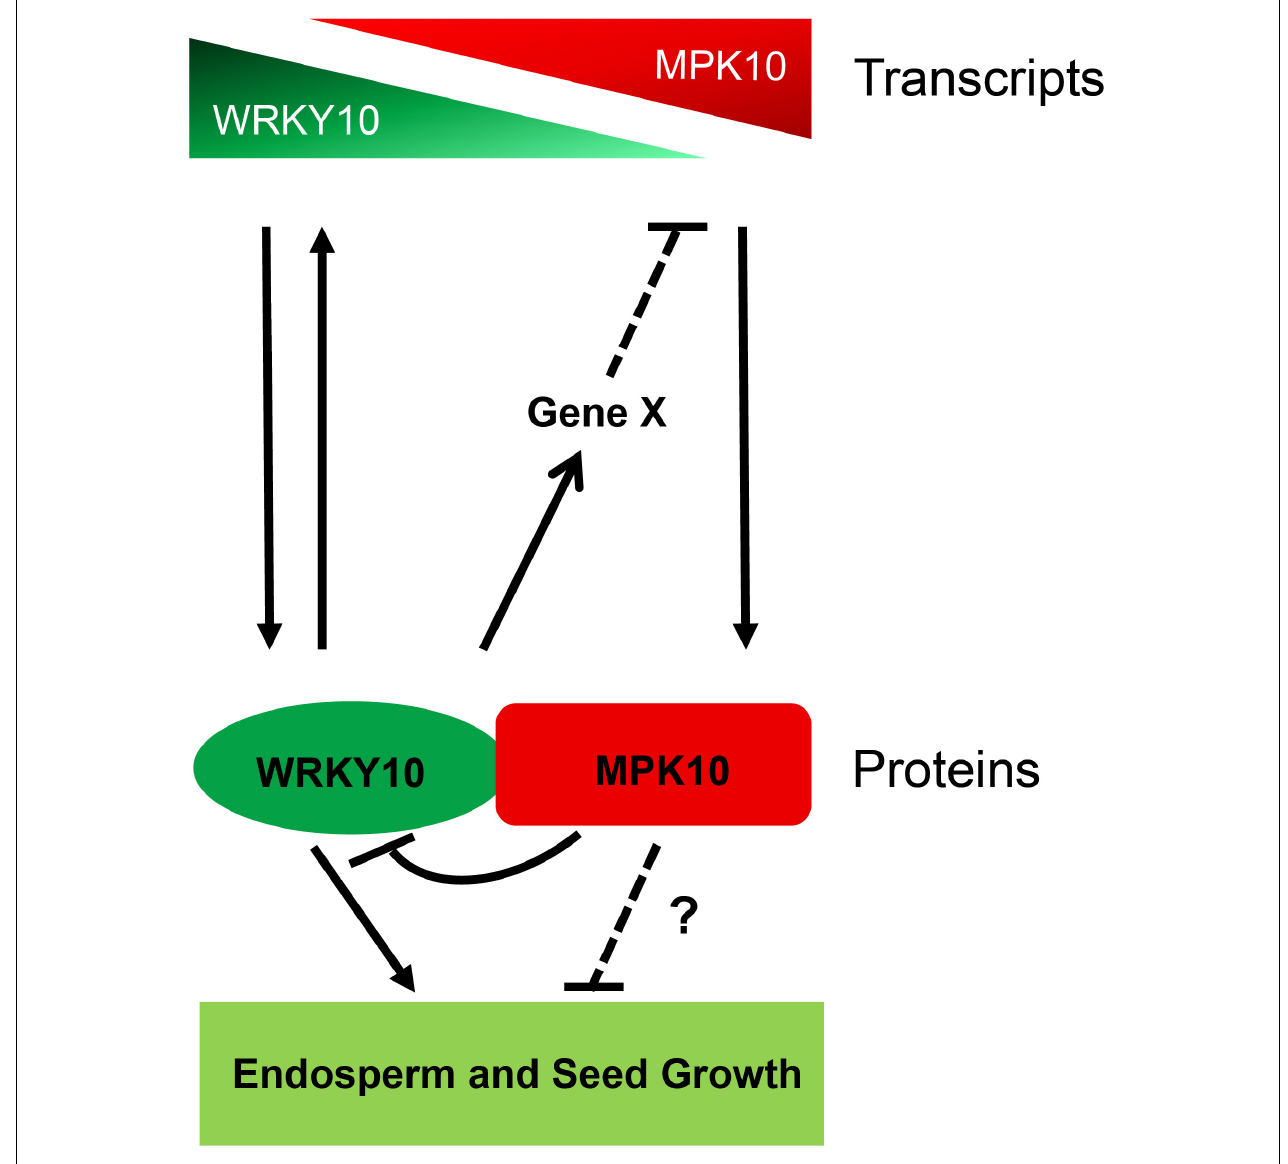
FIGURE 6 | The model of MPK10 and WRKY10 in seed growth. MPK10 and WRKY10 are specifically expressed in endosperm but with opposite gradients. MPK10 inhibits the transcriptional activity of WRKY10, vice versa , WRKY10 negatively regulates the expression of MPK10 through an unknown mechanism. Overall, the MPK10 influences seed growth likely through fine tuning the transcriptional activity of WRKY10, but we cannot exclude whether MPK10 regulates seed growth through other unknown